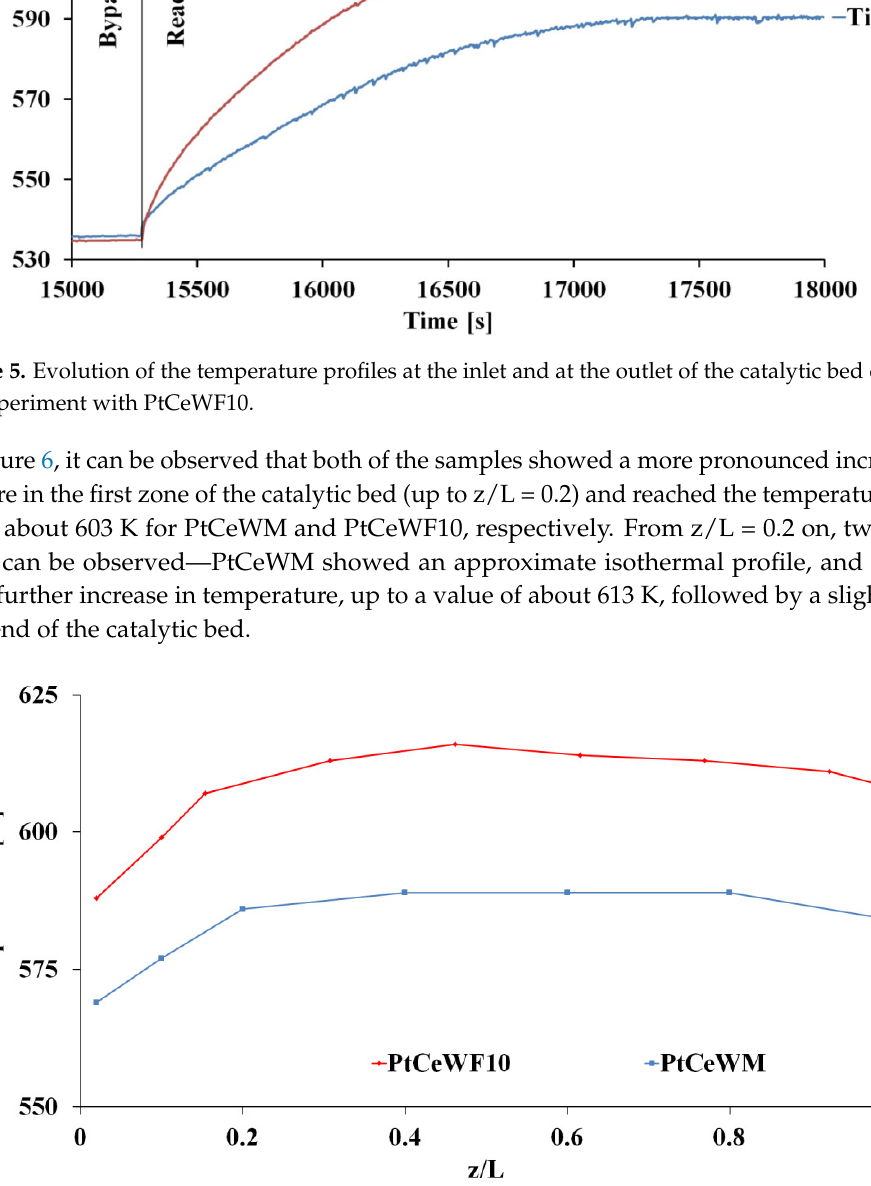
Figure 6. Comparison between the temperature profiles on the catalytic bed at the thermal equilibrium of PtCeWF10 and PtCeWM.